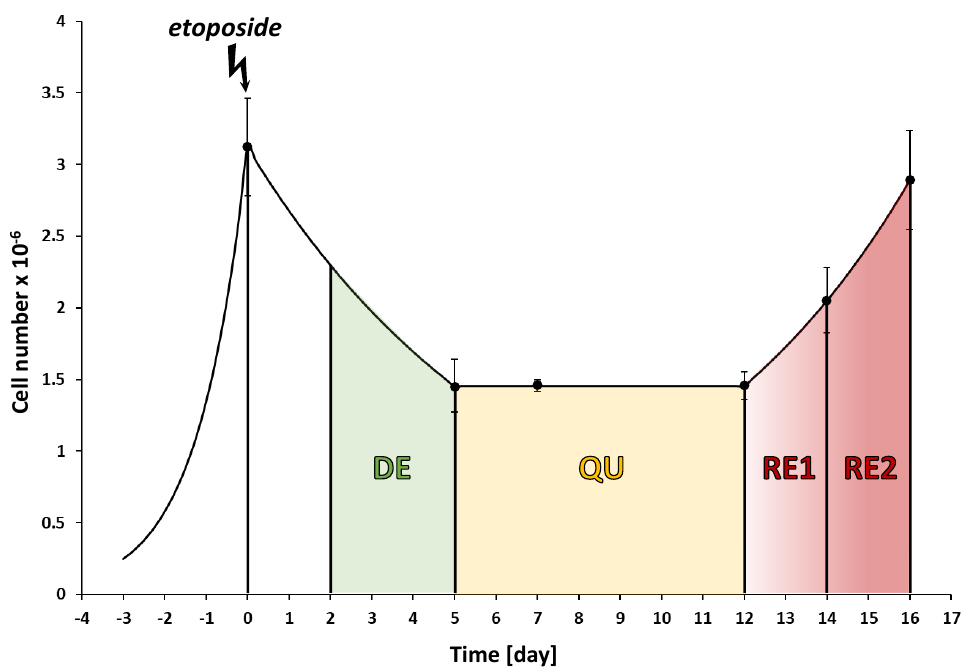
Figure 1. Evolution of the culture after etoposide treatment: DE, QU, RE1, and RE2 represent the degenerative, quiescent, and repopulation phases. Vertical lines indicate medium changes; the colored areas show the successive stages of CRAC. Each dot represents the time when cells were counted, and the bar is the corresponding standard deviation of its